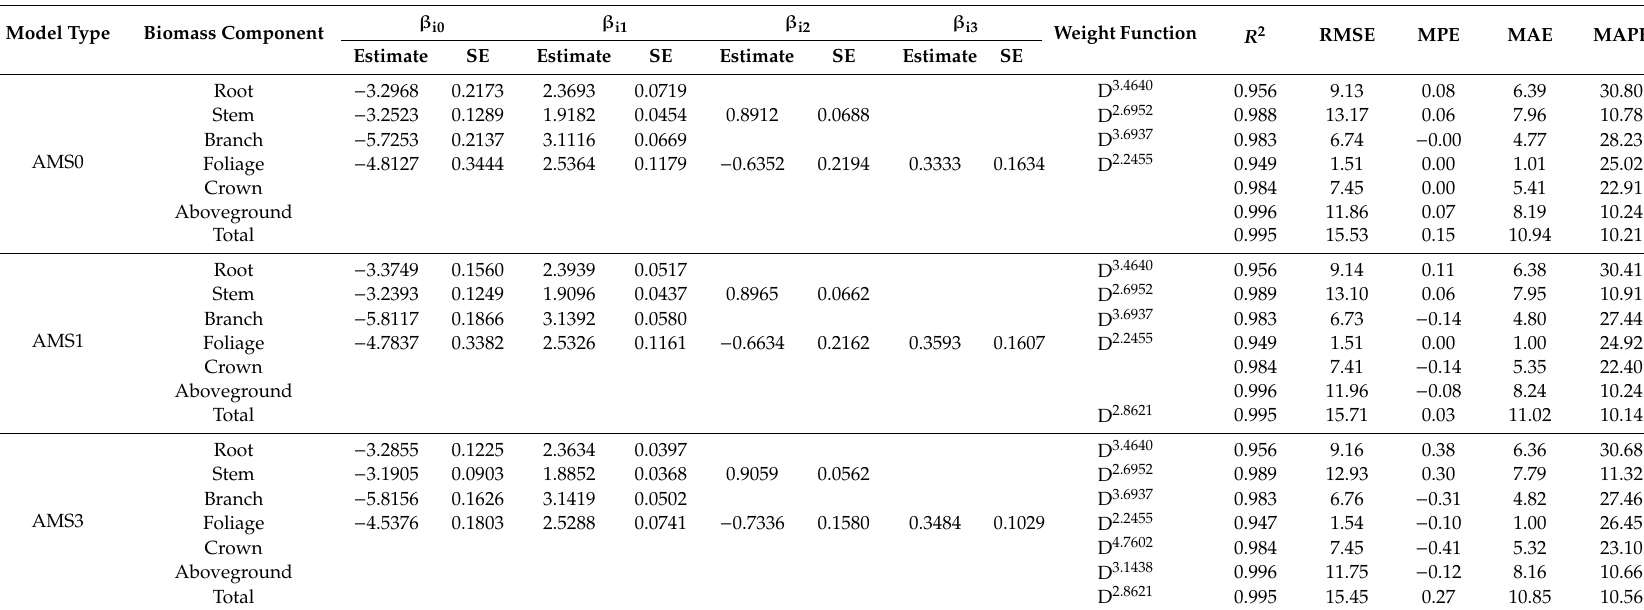
Table 6. Parameter estimates, standard errors (SE), model fitting statistics, weighting functions, and jackknifing validation for AMS0, AMS1, and AMS3 based on a combination of D, H, and